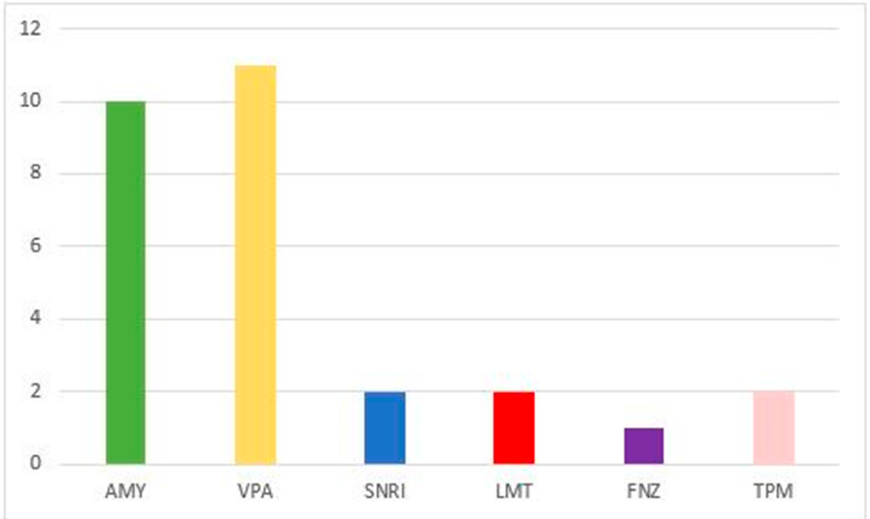
Figure 2. Drugs used concurrently with OBT-A initiation